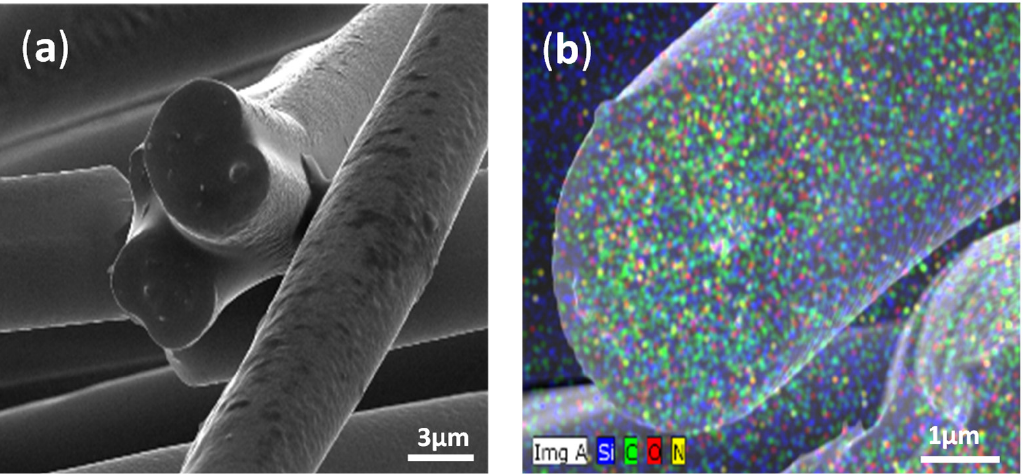
Figure 2. ( a ) SEM image of a cross-section of a fiber. ( b ) SEM-EDX images with mapping of chemical elements of the optimized PS/PDMS 1:1:10 (g/g/mL) fiber mats, including C, O, N, Si. AFM was performed to provide detailed information about surface